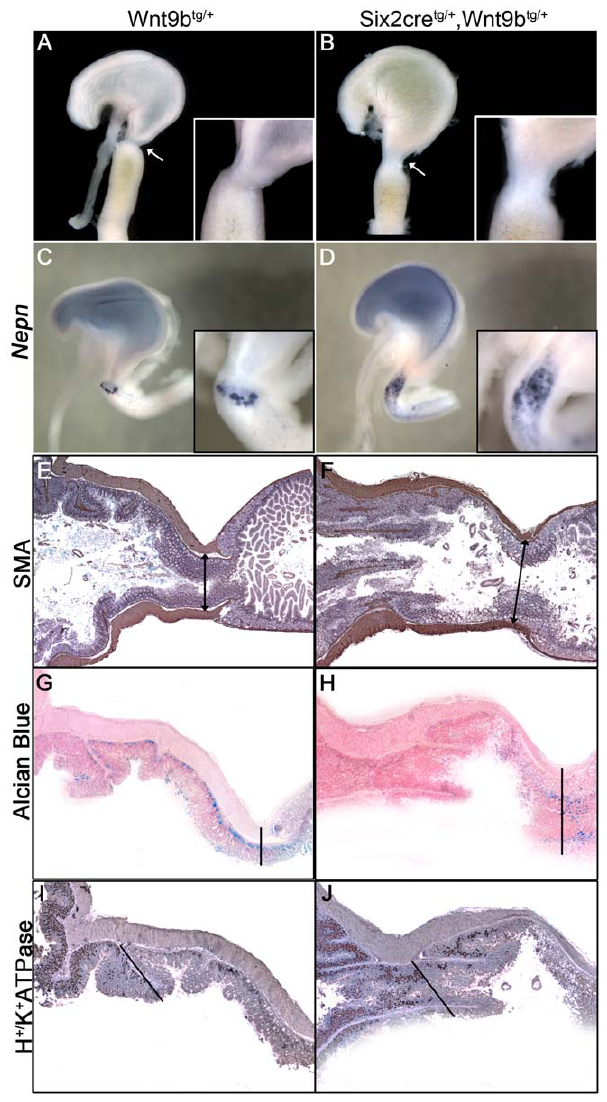
Figure 6. Duodenogastric reflux and pyloric sphincter abnor- malities in Six2 -cre tg/ + , Wnt9b tg/ + double heterozygotes. (A, B) Yellow amniotic fluid refluxed into the stomach of E18.5 double heterozygotes, but was properly retained in the intestine in control animals. A lack of constriction (arrow) and an increased diameter (inset) suggests that the reflux is due to a malformed pyloric sphincter. (C, D) Whole mount staining for Nephrocan mRNA delineates a thin band demarking the sphincter at E16.5 that is expanded in the double heterozygotes. (E, F) Smooth muscle actin staining in sections from control adult stomach demonstrates a thick muscular layer that leads to the sphincter. Double heterozygotes exhibit a thickened muscular layer; however it does not coalesce at the point of highest constriction. Vertical lines mark the transition from antral stomach (left side) to duodenum (right side) in E–H. (G, H) Alcian blue stains mucosal cells in the antral stomach in control sections and these cells are absent in the double heterozygotes. Mucosal cells in the intestine are stained normally. (I, J) Staining for the H + /K + ATPase detects parietal cells in the forestomach that are excluded from the distal stomach. These cells are found throughout the distal stomach and pylorus in double heterozygotes. Sections depicted in panels I and J highlight the transition between forestomach and distal stomach (diagonal line) and do not include the duodenum.